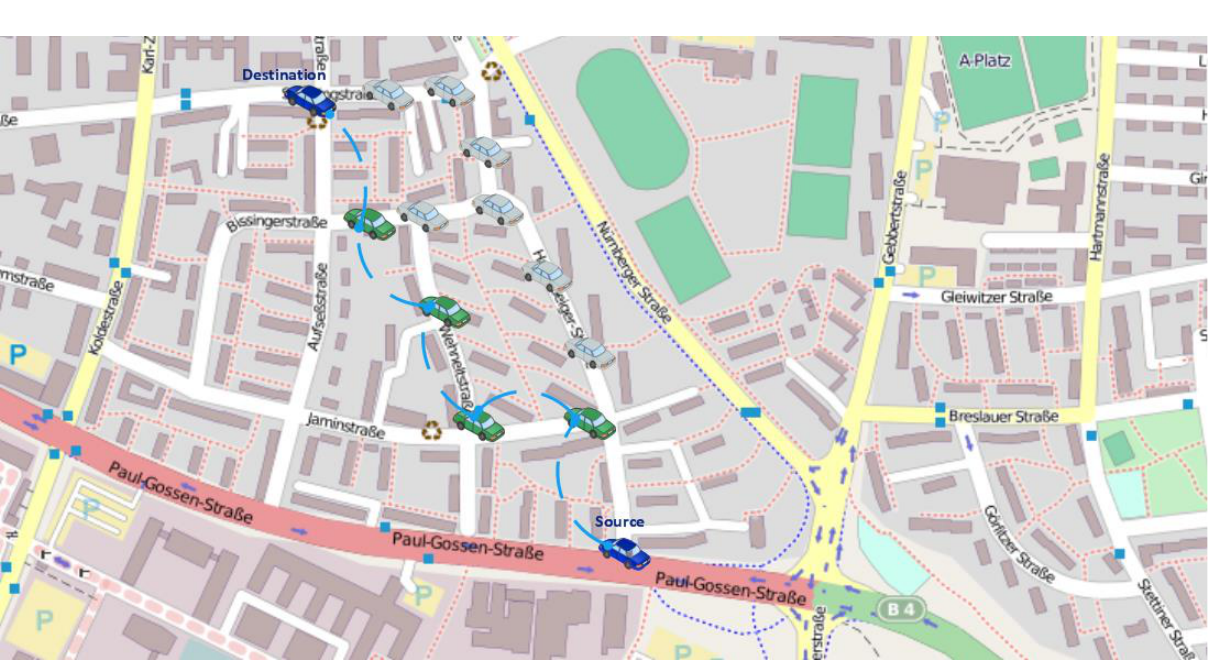
Figure 7. Next-hop selection from source to destination.